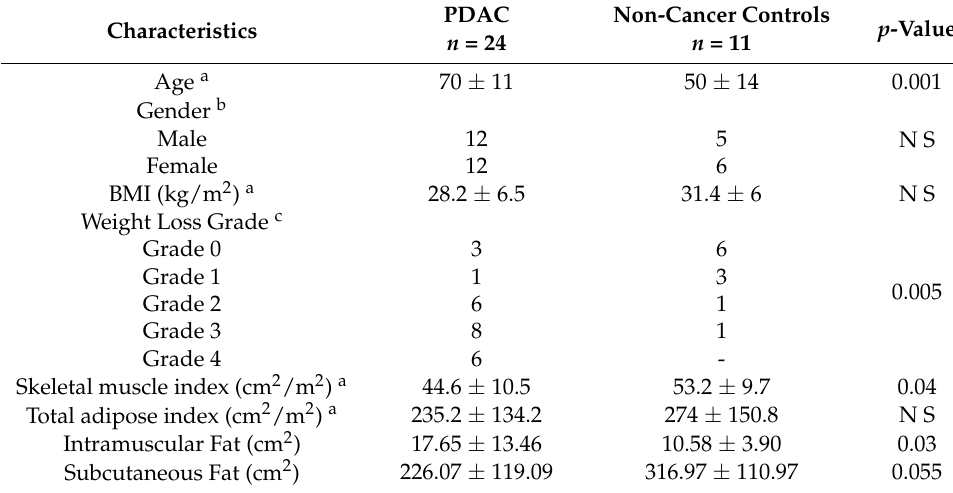
Table 1. Patient demographics.